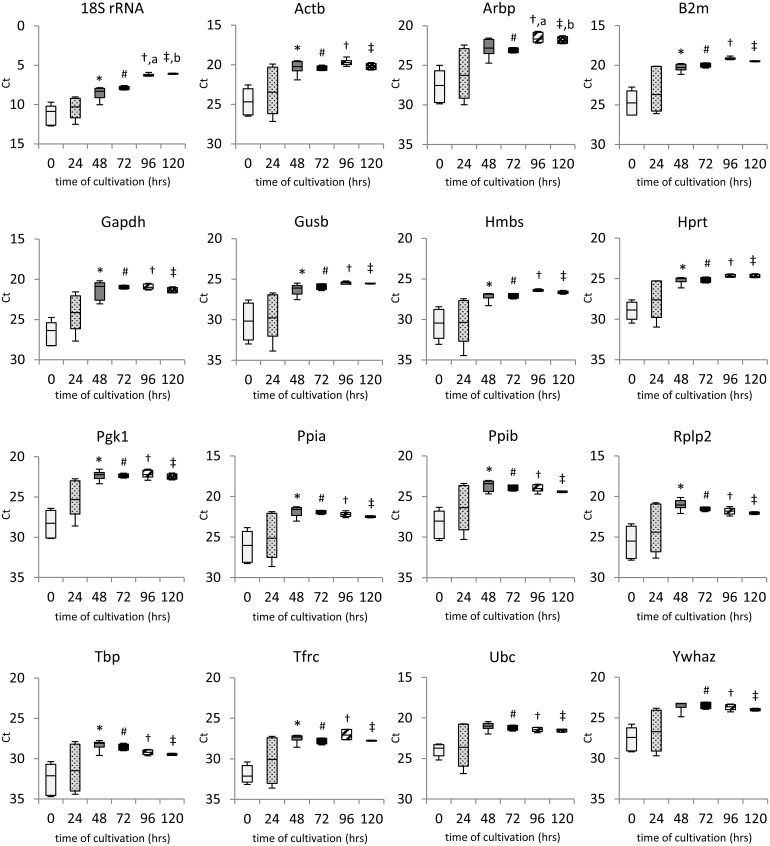
Expression of candidate reference genes during cultivation.Ct of individual candidate genes are shown as medians (lines), 25th percentile to the 75th percentile (boxes) and as ranges (whiskers) immediately after isolation and at 24, 48, 72, 96 and 120 hrs of cultivation. Data are based on at least 6 independent experiments. Statistical significance of the differences in Ct values was evaluated using Freidman’s Two Way ANOVA and multiple comparison method; *p < 0.05 48 vs. 0 hrs; # p < 0.05 72 vs. 0 hrs; †p < 0.05 96 vs. 0 hrs; ‡ p < 0.05 120 vs. 0 hrs; a p < 0.05 96 vs. 48 hrs; b p < 0.05 120 vs. 48 hrs.